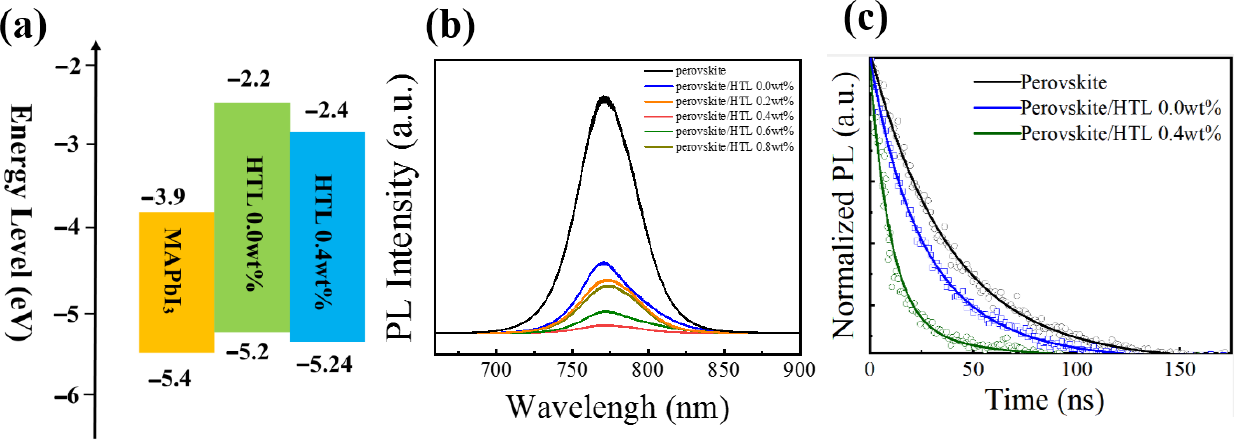
Figure 6. ( a ) UPS diagrams of HTL 0.0 wt% and HTL 0.4 wt% films: Eonset area (left), Ecutoff area (right). ( b ) Ultraviolet-visible absorption spectra of Spiro-OMeTAD doped with different CsI con- tent. ( c ) magnified image of the oxidized Spiro-OMeTAD peak at 440 – 560 nm. ( d ) Tauc plots of the HTL 0.0 wt%t and HTL 0.4 wt%.